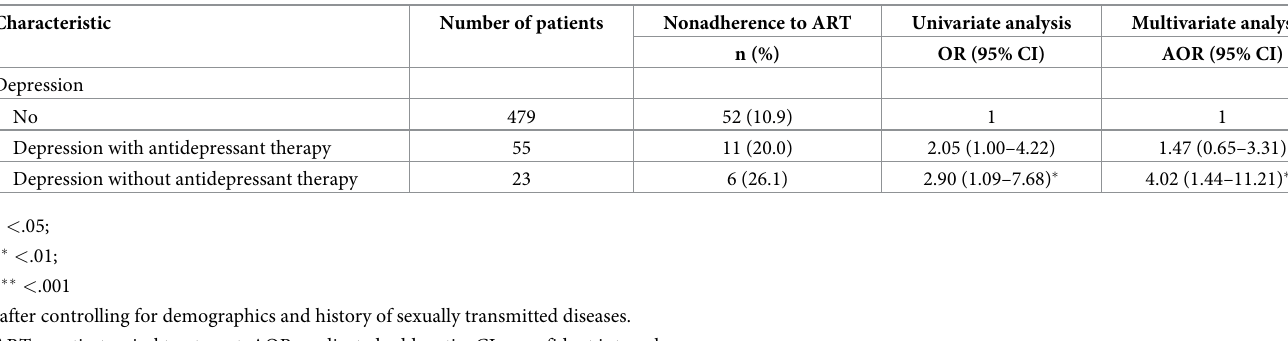
Table 3. Univariate and multivariate analyses of the association between depression and adherence to antiretroviral therapy among HIV-infected MSM. Characteristic